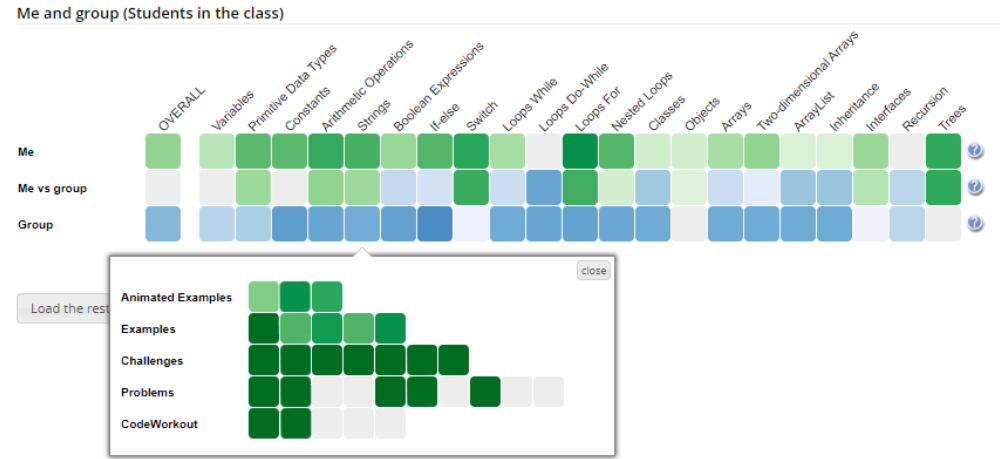
Figure 11. Mastery Grids interface prepared for a Java course. The available smart learning contents are shown for the topic Strings including integrated CodeWorkout coding exercises.